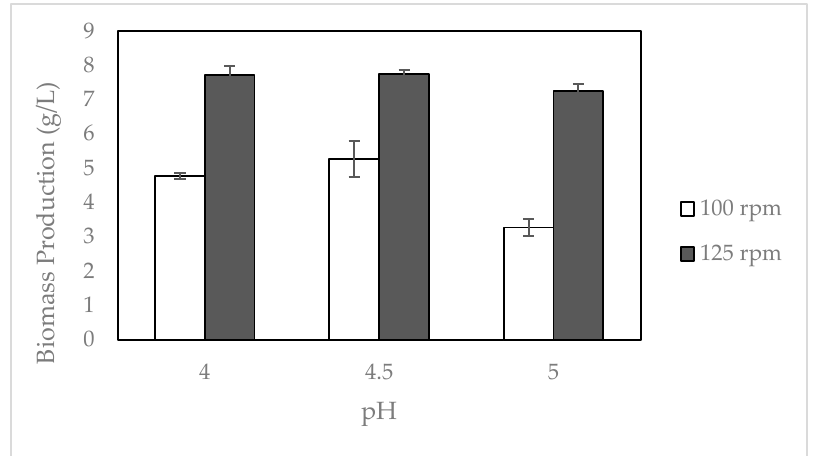
Figure 3. Biomass of R. oligosporus cultivated in residual boiling water of tempeh processing under di ff erent pH and aeration rates of 100 rpm ( □ ) and 125 rpm ( ■ ).